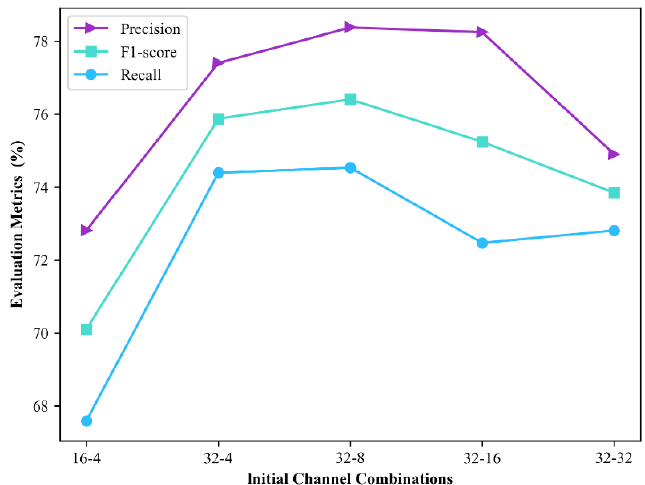
Remote Sens. 2022 , 14 , x FOR PEER REVIEW